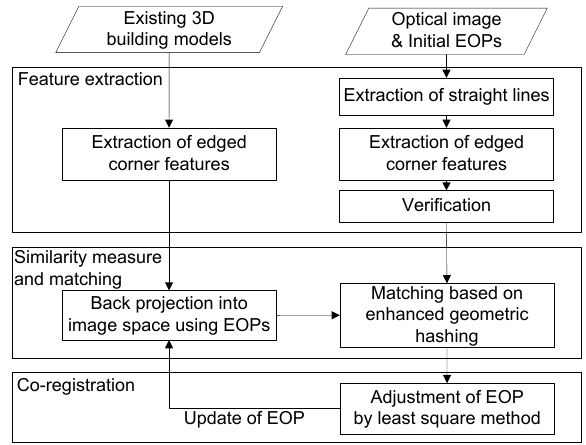
Figure 1. Flowchart of the proposed model-to-image registration